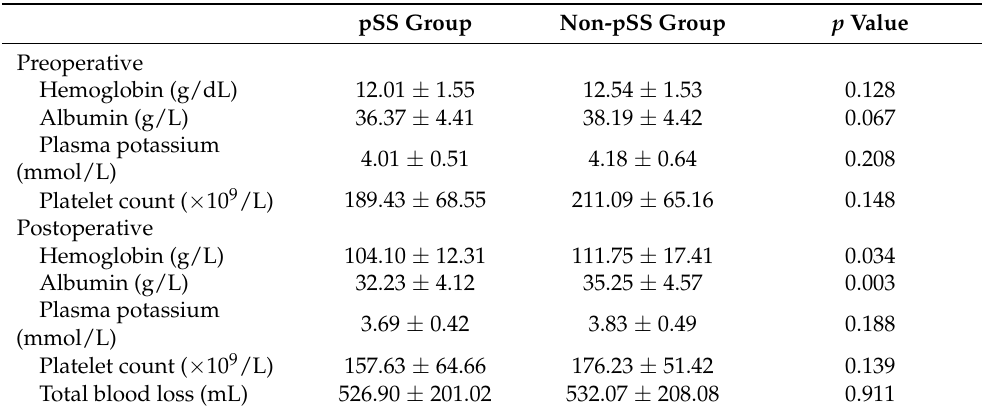
Table 4. Perioperative hematological